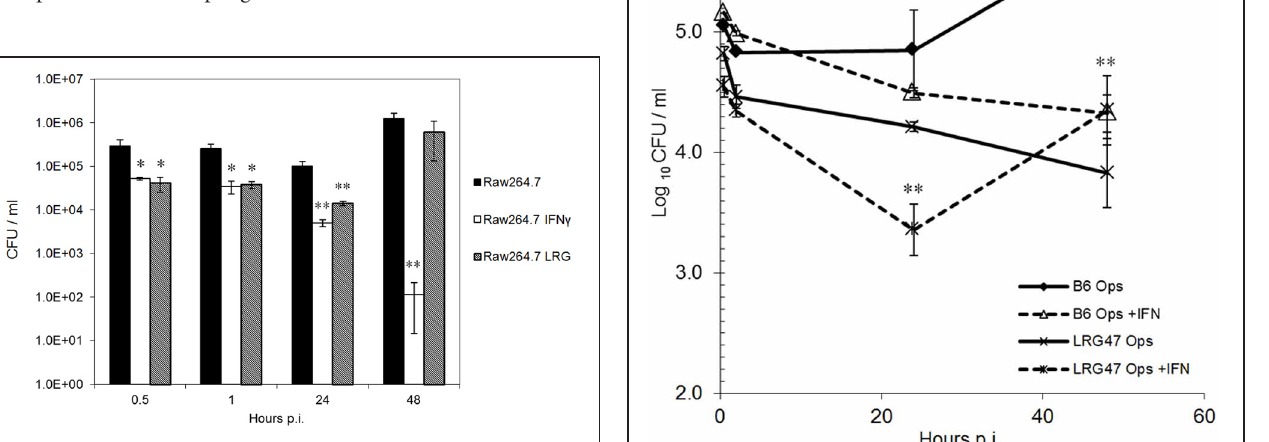
FIGURE 3 | Intracellular viability of Brucella in peritoneal macrophages harvested from C57/B6 and LRG47 knockout mice. IFN- γ was added 24h prior to infection with immunoglobulin opsonized B. abortus 2308. Values and standard deviations were calculated from triplicate samples ( ∗∗ p ≤ 0 . 01 Student’s t -Test compared to C57/B6 Ops). Results shown are representative of three independent experiments demonstrating similar significant